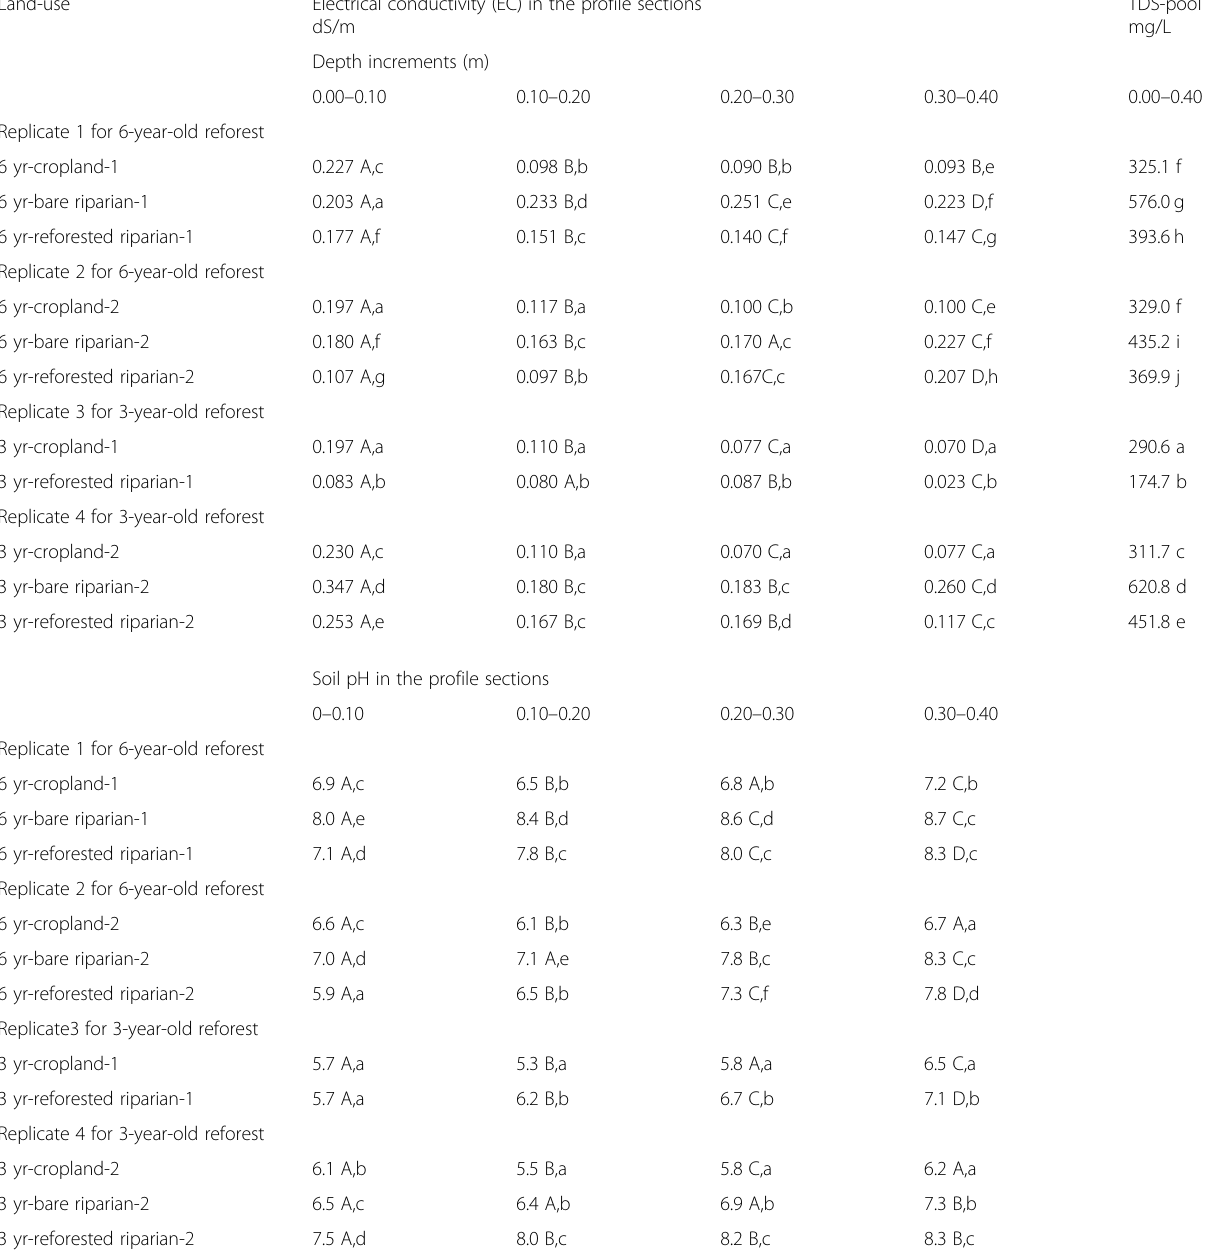
Table 4 The summary of mean separation analysis for electrical conductivity (EC) and pH distributions at 0.10 m depth increments and for the total dissolved solutes (TDS-total) in soil profiles along the four transects to determine whether they were impacted by land-use practices and/or the physical locations of the transects in the farm. During the experimental design stage, two out of the four transects were considered as replicates for the 3-year-old reforested riparian (RR) and the corresponding cropland (CP) and bare riparian (BR) land-uses and the other two transects as replicates for the 6-year-old RR, CP and BR land-uses